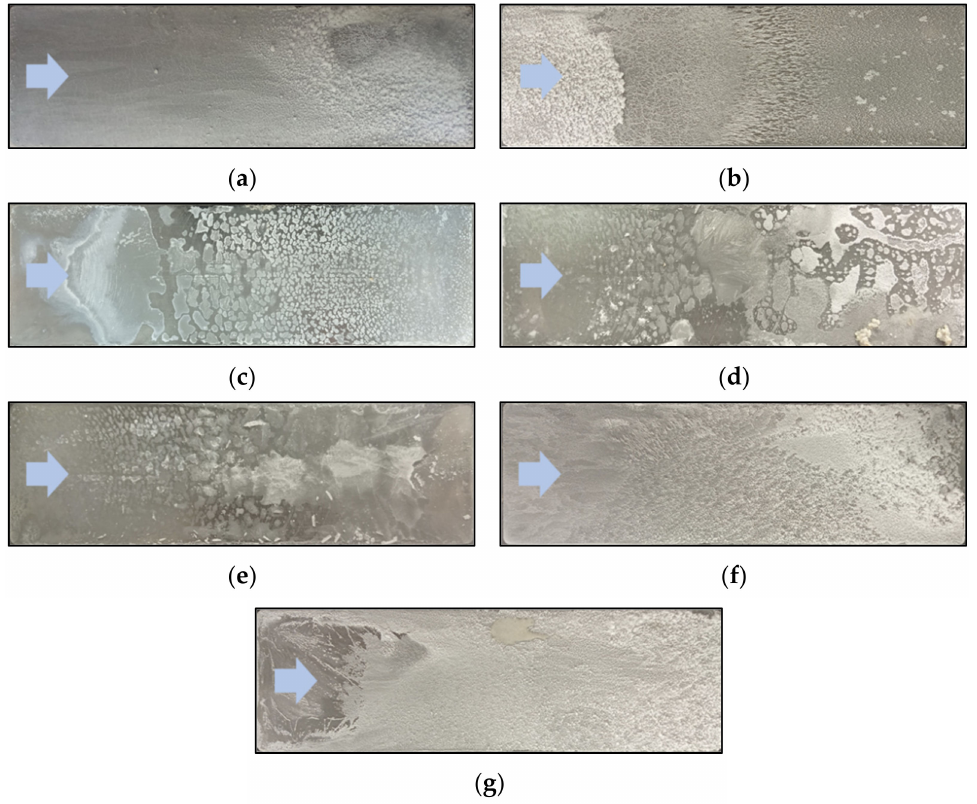
Figure 9. Deposits after the end of AdBlue injection and evaporation of the water: ( a ) 180 ◦ C, 6.5 m α = 1; ( c ) 250 ◦ C, 6.5 m